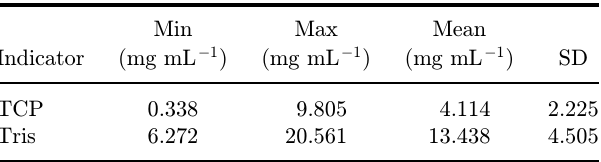
Fig. 3. 2D distribution of TCP and Tris concentrations in 72 TCP – Tris – HCl mixture samples.